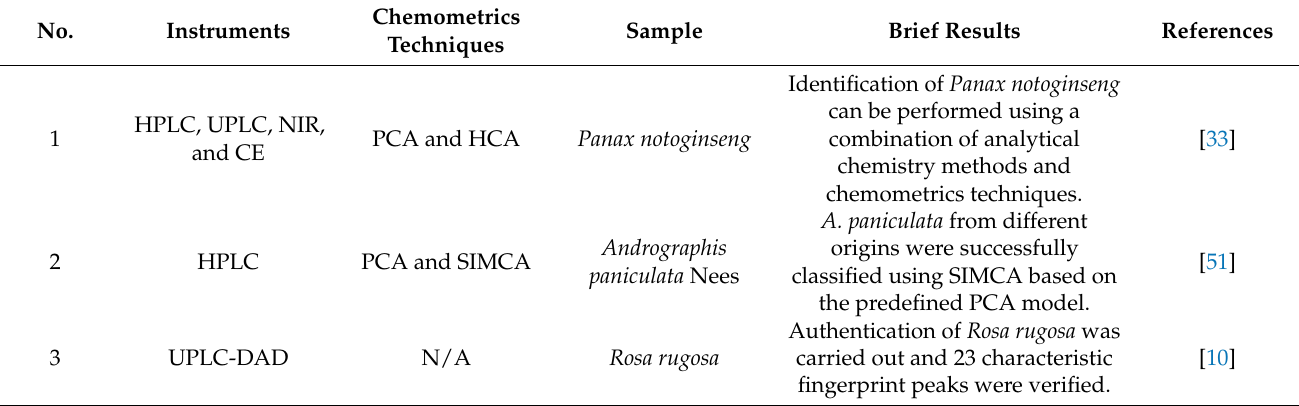
Figure 2. The simplified strategy illustrating the use of HPLC or LC–MS/MS for herbal identification intended for authentication analysis. X and Y represent the matrixes of input and output. RT represents retention time. Peak area and m/z are variables typically used during chemometrics analysis. Adapted from [31]. Table 1. List of publications on HMs’